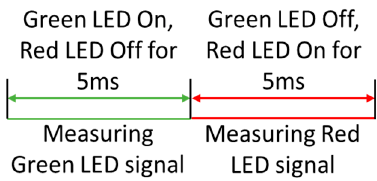
Figure 6. Switching states of red and green LEDs at 100 Hz .